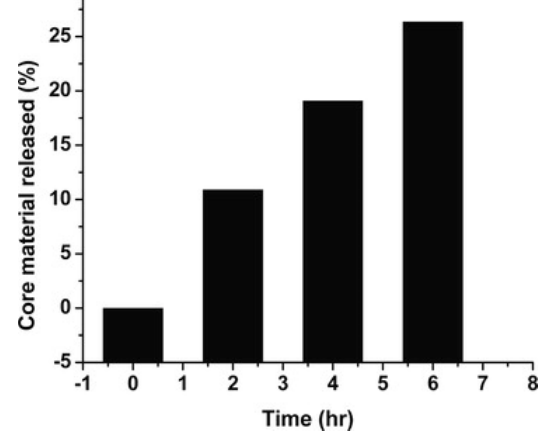
Figure 19. Controlled release of core material over time [201].